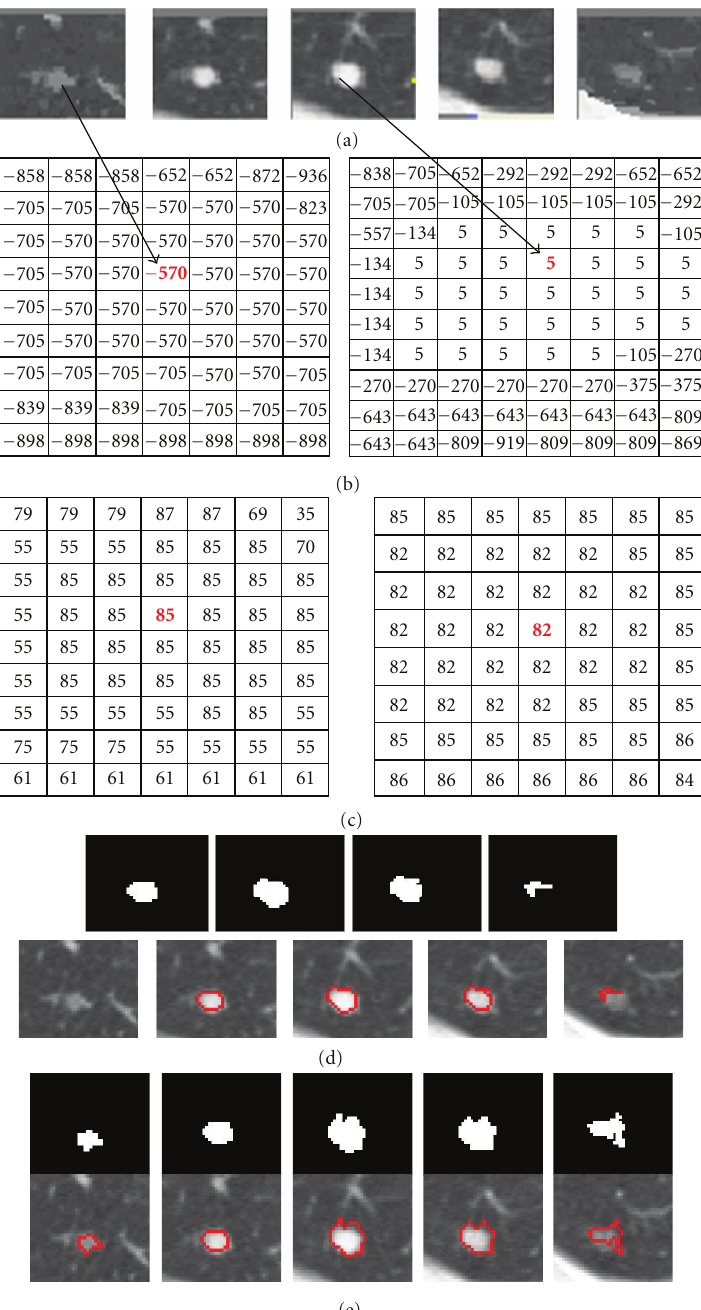
Figure 9: An example of a solid nodule (attached to a small vessel) segmentation. (a) Original 3D nodule on 5 contiguous slices; (b) and (c) intensity and shape index (multiplied by 100) mode maps from 5D mean shift clustering; (d) segmentation results without considering the shape feature; (e) results based on the proposed